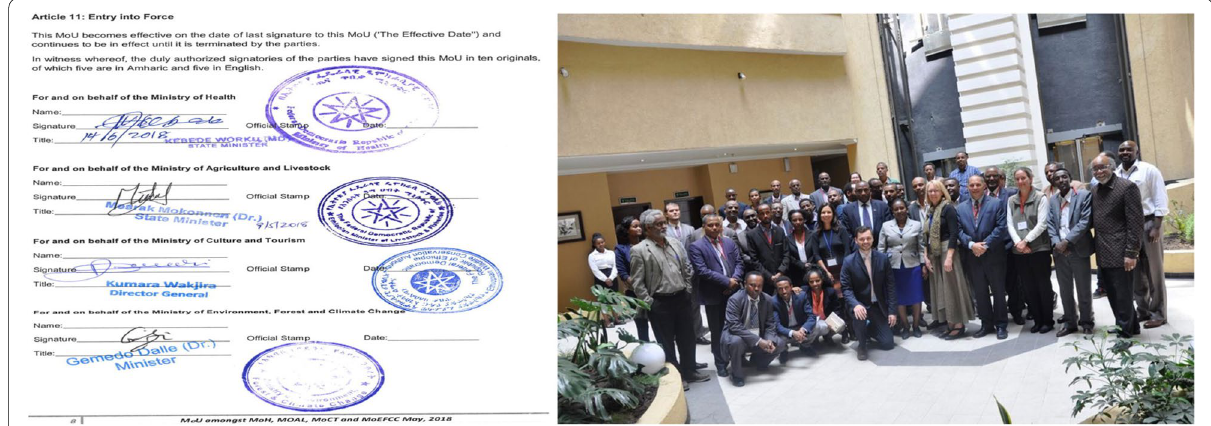
Fig. 3 The founding members of Ethiopian National One Health Steering Committee and the Signed Memorandum of Understanding (obtained from NOHSC with